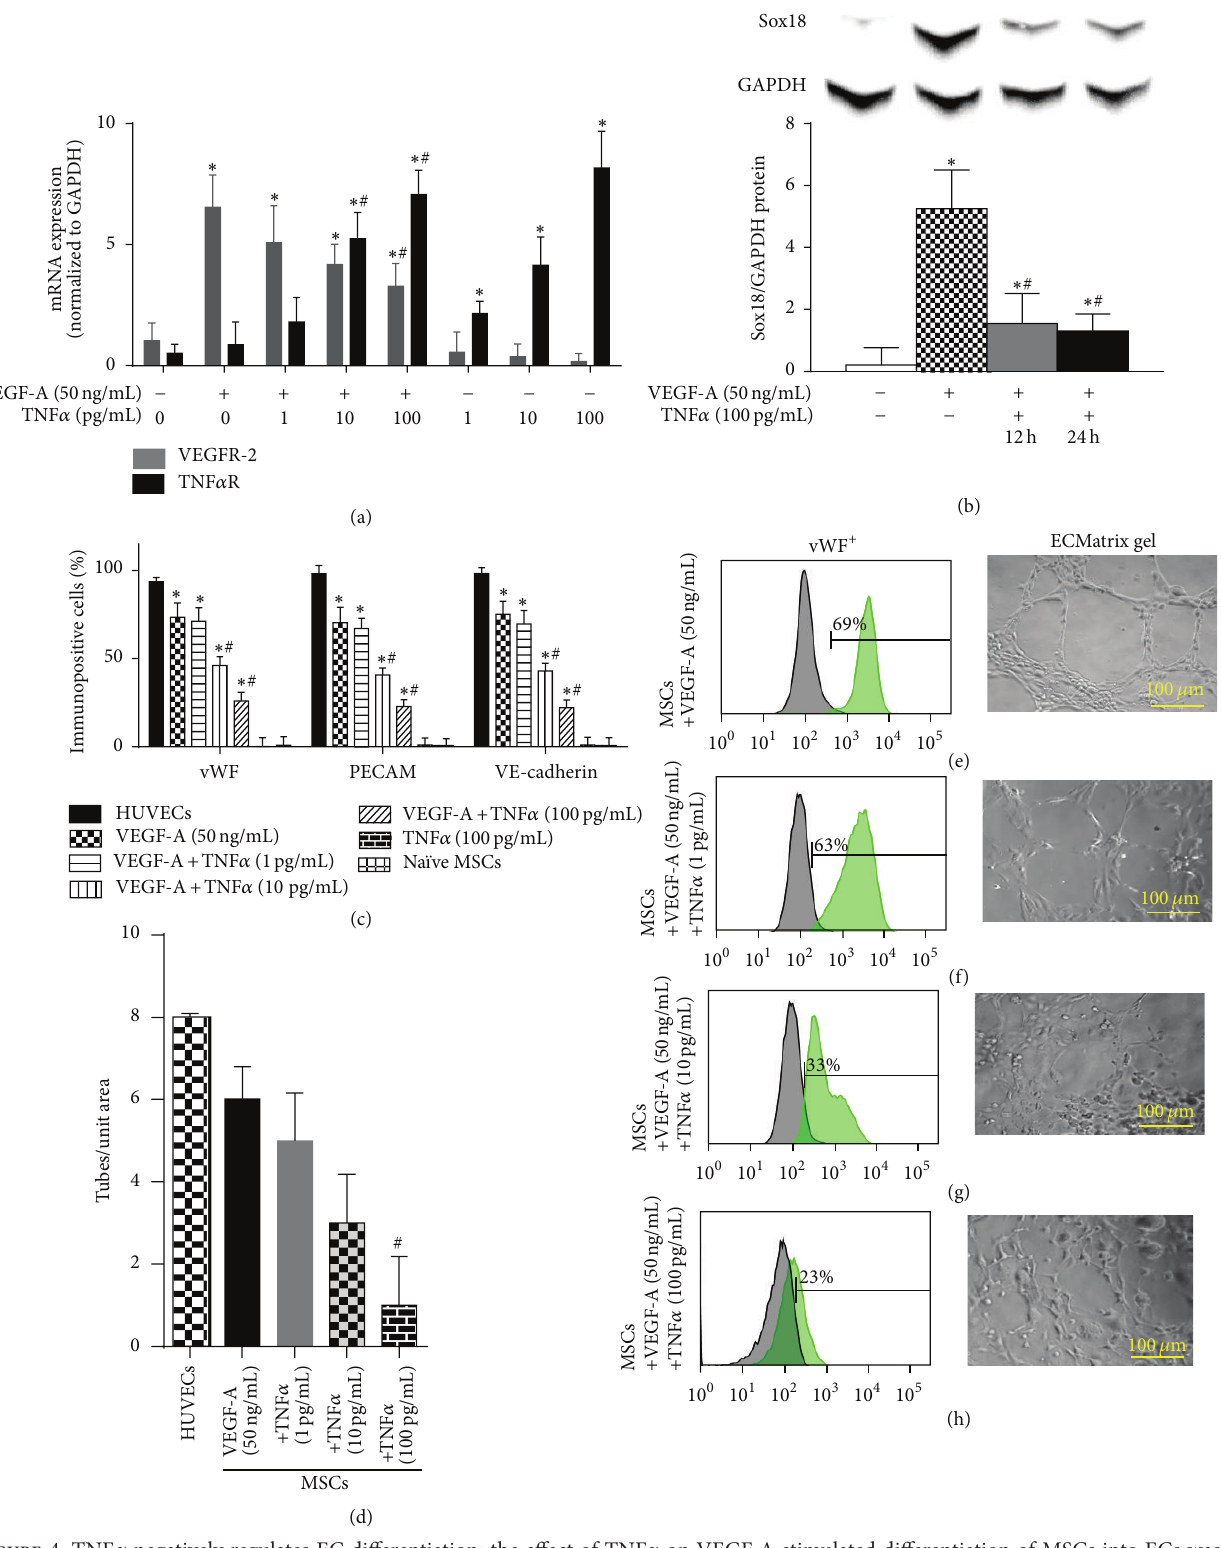
Figure 4: TNF 𝛼 negatively regulates EC differentiation: the effect of TNF 𝛼 on VEGF-A-stimulated differentiation of MSCs into ECs was examined. TNF 𝛼 R and VEGFR-2 mRNA expression was analyzed by RT-PCR ( 𝑛 = 3 ) (a). Sox18 protein levels were measured by Western blot analysis ( 𝑛 = 3 ) (b). Expression of EC markers was determined by FACS analysis, and a representative grid is shown ( 𝑛 = 3-4) ((c)–(g)). Endothelial tube formation was examined using an angiogenesis assay ( 𝑛 = 3 ) ((d)–(h)). Experiments were performed with samples taken from independent BM-MSC cultures from separate microswine. HUVECs were excluded from statistical analyses. Data are shown as mean ± SD. ∗ 𝑝 < 0.05 versus na¨ıve MSCs and # 𝑝 < 0.05 MSCs treated with VEGF-A versus VEGF-A plus TNF 𝛼